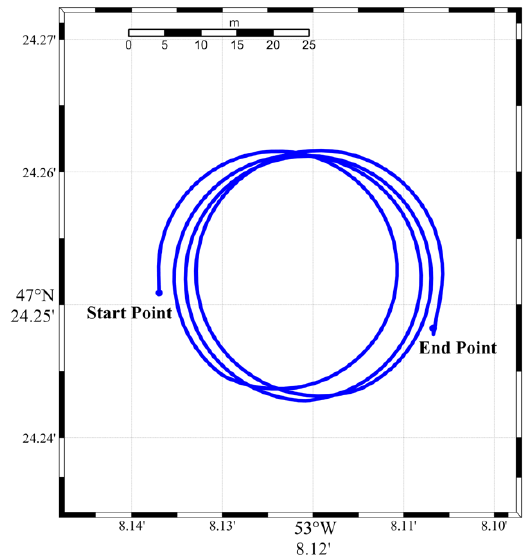
Figure 20. The trajectory of the glider when changing its heading from 0 to 2π continuously for estimating the turning radius of the Slocum G1 glider. estimating the turning radius of the Slocum G1